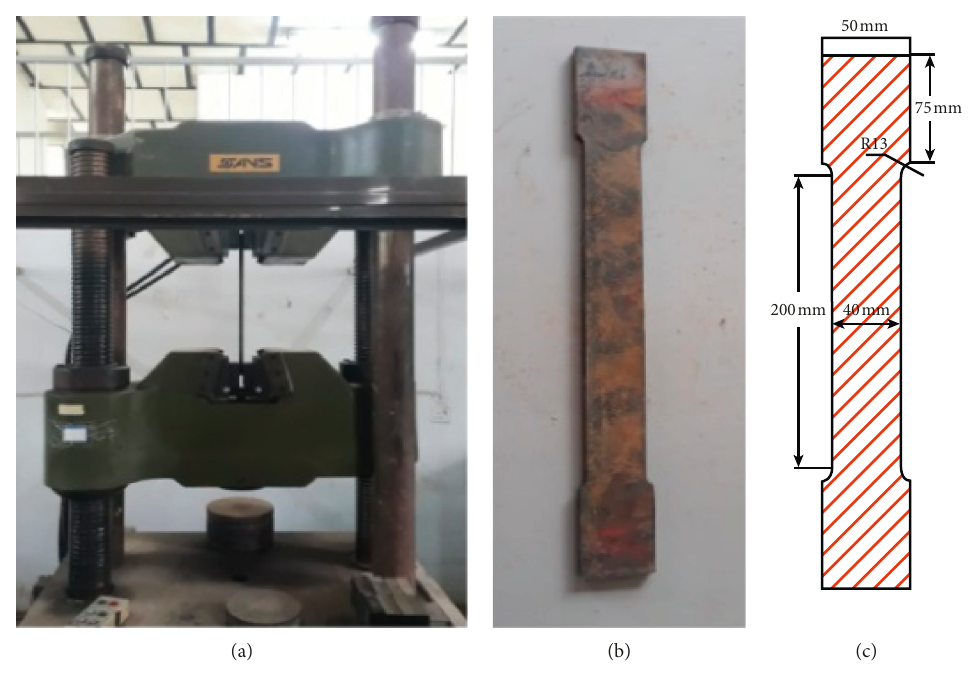
Figure 1: Direct tension test for steel plate. (a) Testing machine. (b) Specimen. (c) Specimen dimensions. Table 2: Mechanical properties of the specimen test based on the direct tension test.